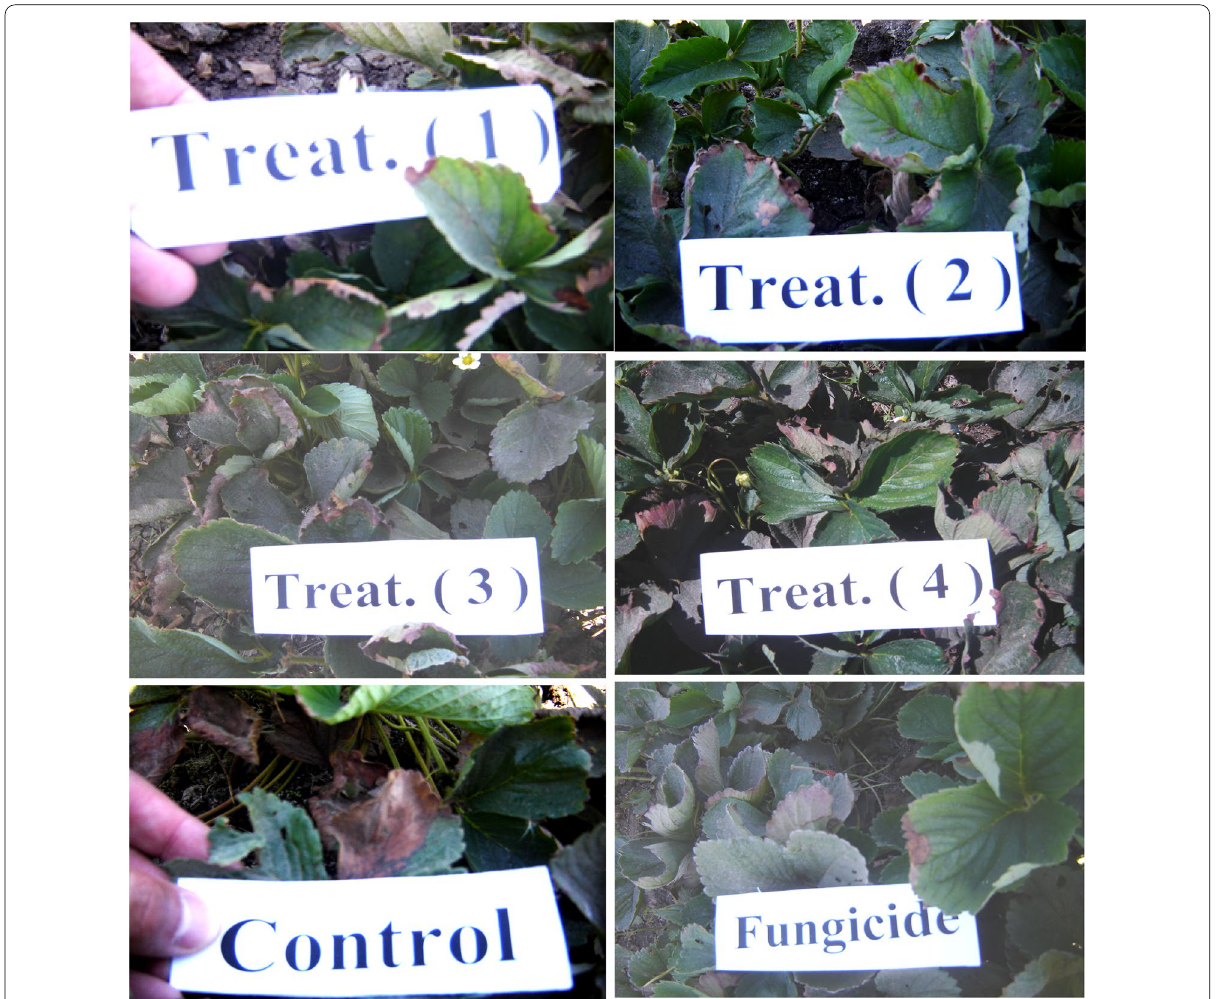
Fig. 1 Lesion symptoms caused by phomopsis leaf blight disease under field conditions in different treatments; 1: Potassium bicarbonate at 1.5%, 2: Potassium bicarbonate at 2.0%, 3: diPotassium phosphate at 1.5%, 4: diPotassium phosphate at 2.0%; in addition to the fungicide (Amstar at 1 ml/l) and the untreated